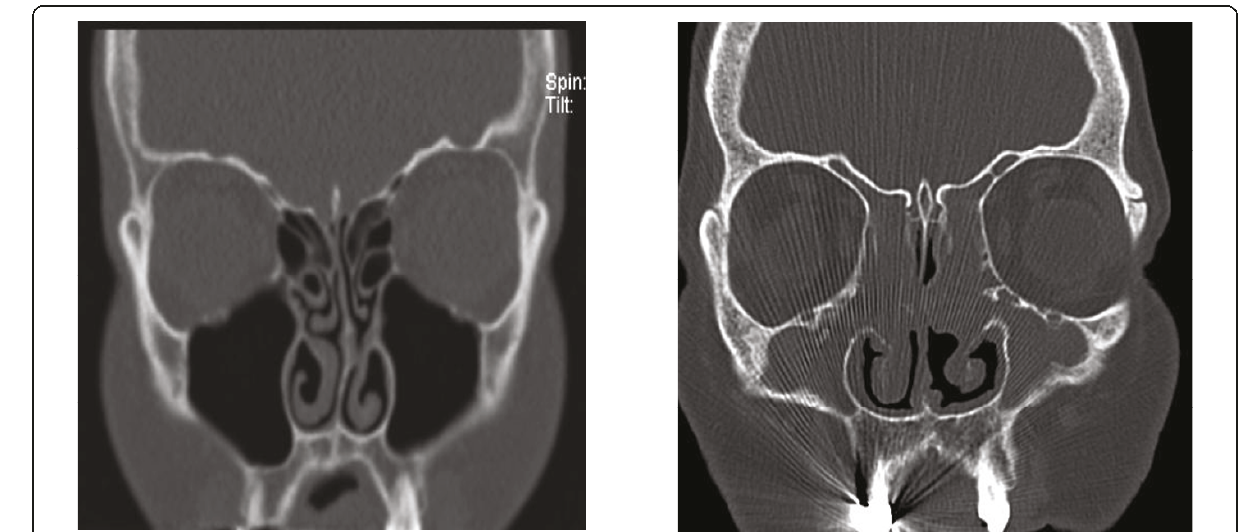
Figure 16 Coronal CT scan images of normal (left) and NP patient (right)